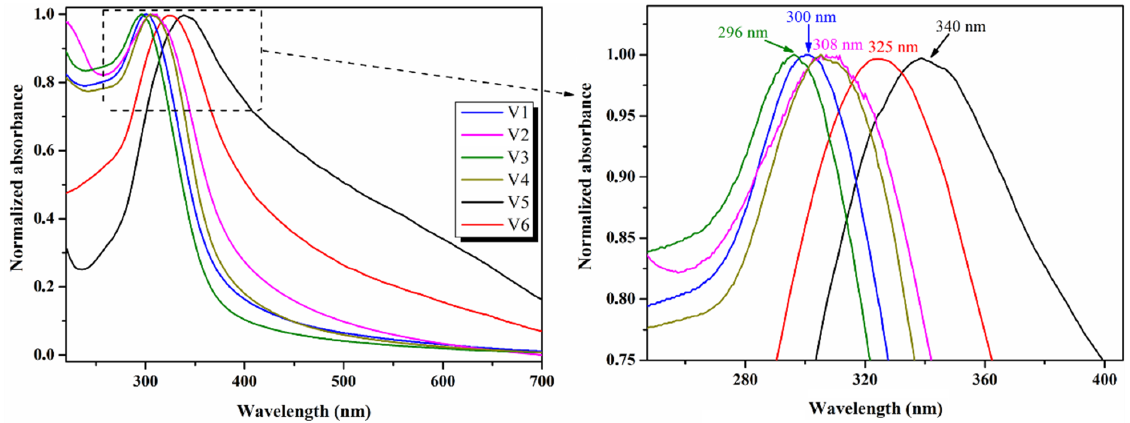
Figure 6. UV–Vis absorption spectra of pristine CeO 2 NPs: V1–V6 samples.